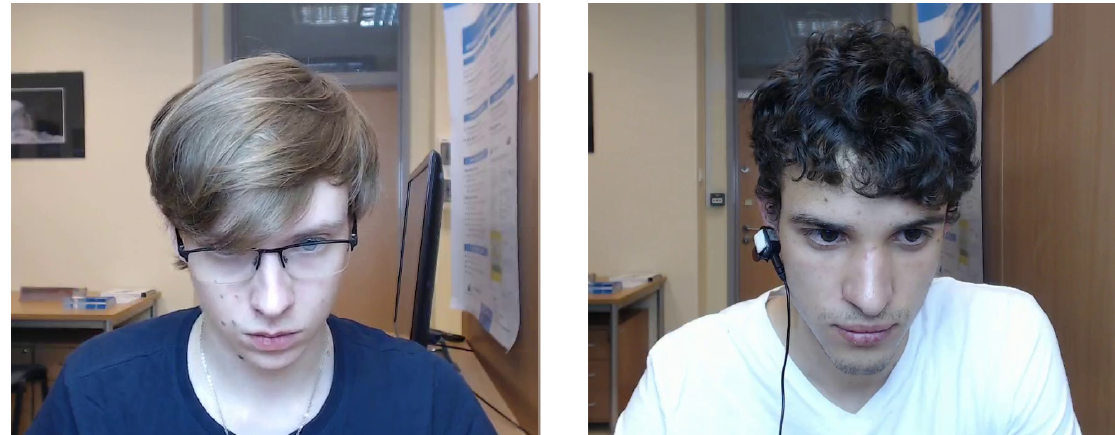
Figure 3. Images of the participants from the video camera: the first with glasses and a long fringe on the left, and another with the blood volume pulse (BVP) sensor attached to the earlobe on the